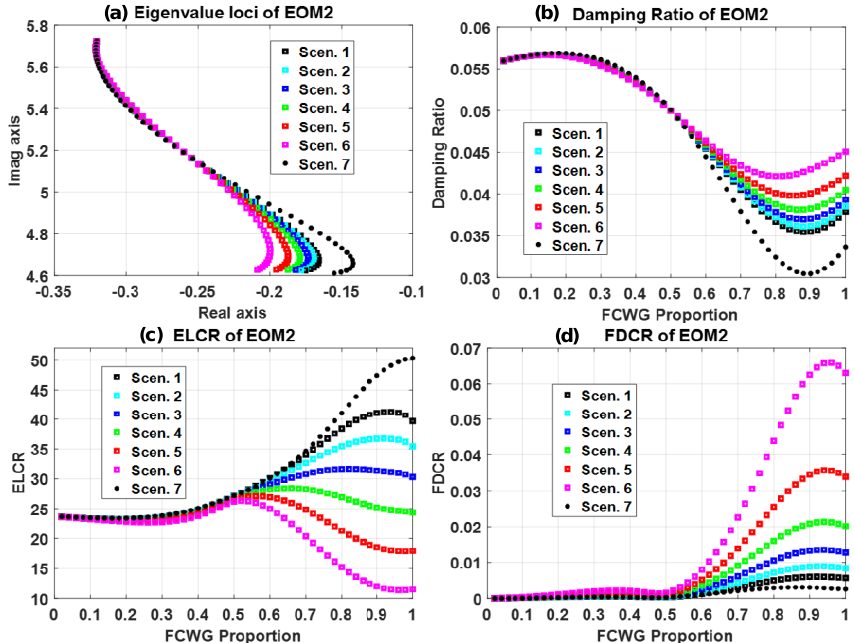
Figure 9. The interaction between PLL-FOM and EOM2 considering increasing FCWG proportion: ( a ) eigenvalue loci; ( b ) variation trend of damping ratio; ( c ) variation trend of ELCR; ( d ) variation trend of FDCR.